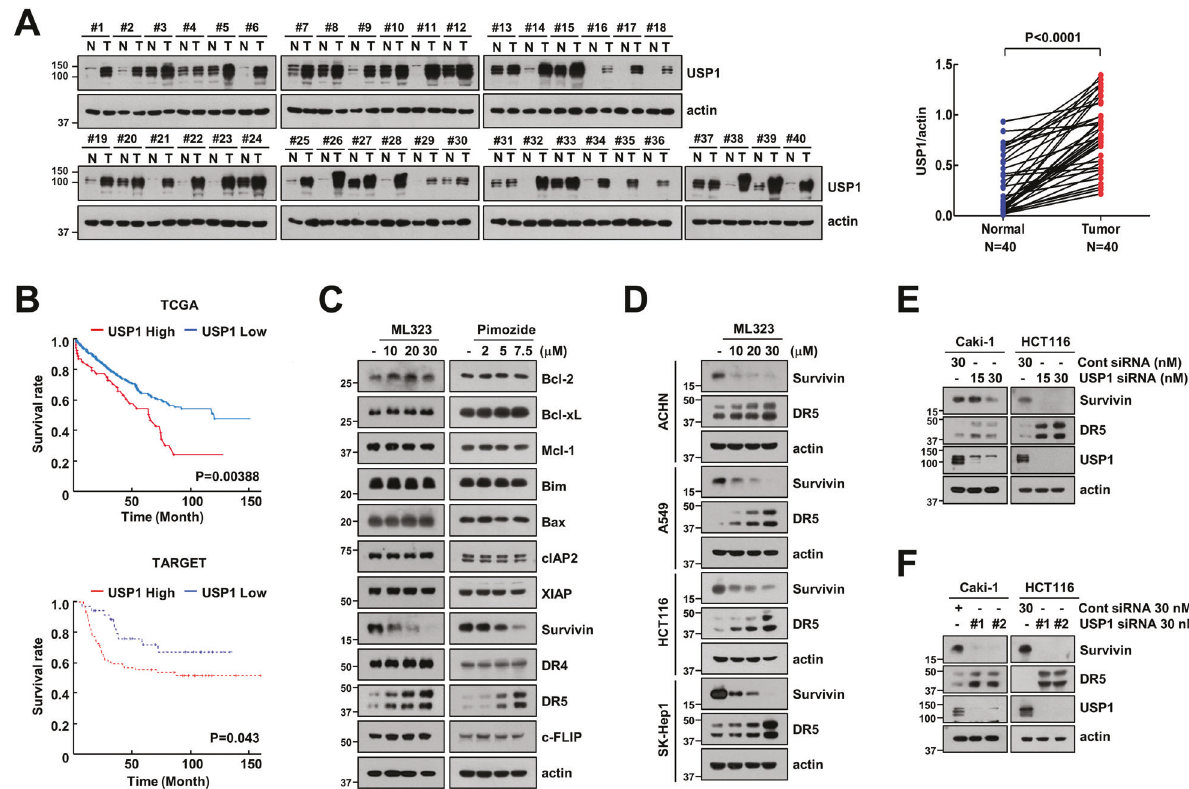
Fig. 1 USP1 is upregulated in human renal clear carcinoma (RCC) tissues. A Examination of USP1 protein expression in 40 paired primary RCC tissues and corresponding normal adjacent tissues. B Analysis of prognostic signi fi cance of USP1 in patients with RCC based on The Cancer Genome Atlas (TCGA, n = 527, upper) and Therapeutically Applicable Research to Generate Effective Treatments (TARGET, n = 124, lower). Investigation of apoptosis-related protein expression in cancer cell lines treated to 10 – 30 μ M ML323 ( C ) or 2 – 7.5 μ M pimozide ( D ) for 24 h. E, F The cancer cells were transfected with control siRNA or USP1 siRNA for 24 h. Protein expression was measured using western blotting ( A , C – F